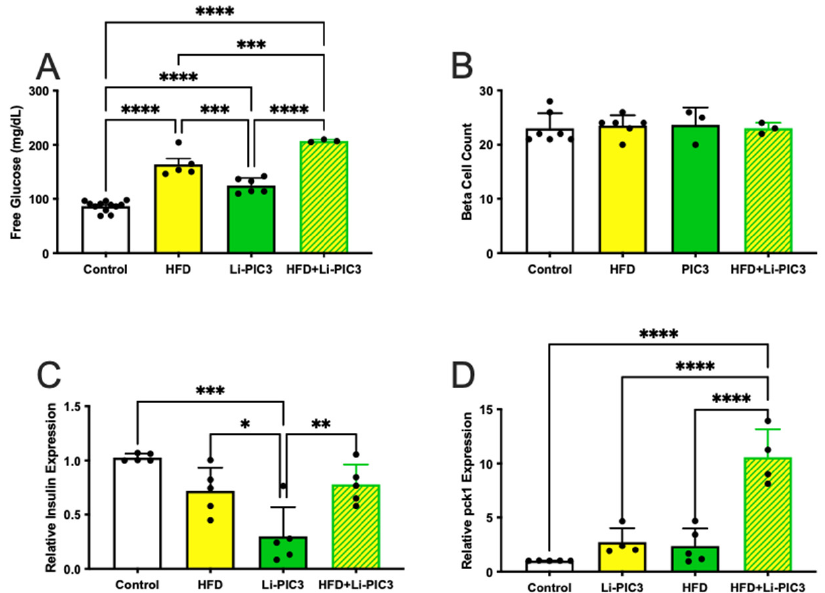
Figure 5 . Hyperglycemia is induced without loss of β cells in HFD, Li-PIC3, and Li-PIC3+HFD larvae. ( A ) Blood glucose levels for Tg(fabp10:cre), HFD, Li-PIC3, and Li-PIC3+HFD larvae. ( B ) β cell count in Tg(fabp10:cre), HFD, Li-PIC3, and Li-PIC3+HFD larvae. ( C ) Transcript levels for insulin Tg(fabp10:cre) , HFD, Li-PIC3, and Li-PIC3+HFD larvae. ( D ) Levels of pck1 , a marker of gluconeogen-